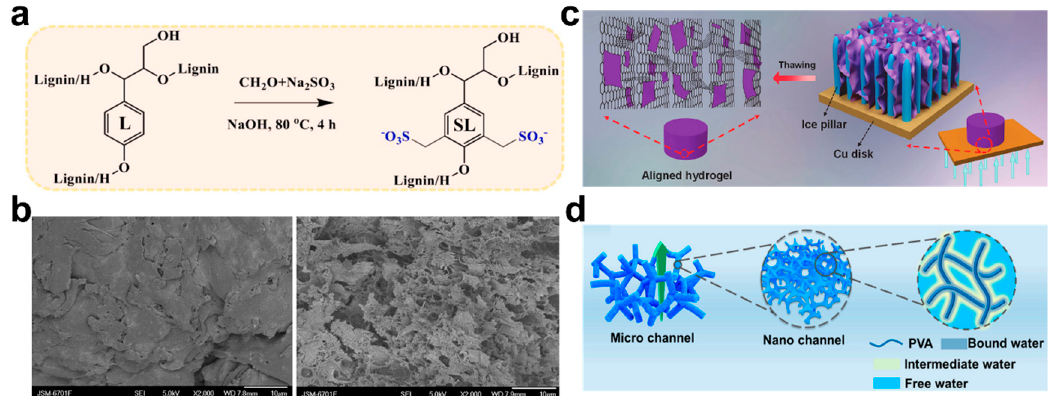
Figure 7. ( a ) Sulfonomethyl treatment of lignin. Reprinted with permission from Reference [95]. ( b ) SEM micrographs of SA-g-PNaA (left) and SA-g-PNaA/PVA (right). Reprinted with permission from Reference [98]. ( c ) Schematic diagram of Ti 3 C 2 Tx MXene coated vertical channel reduced graphene oxide (A-RGO) hydrogel. Reprinted with permission from Reference [100]. ( d ) Exhibition of hierarchical channel structure in the hydrogel. Reprinted with permission from Reference [101].